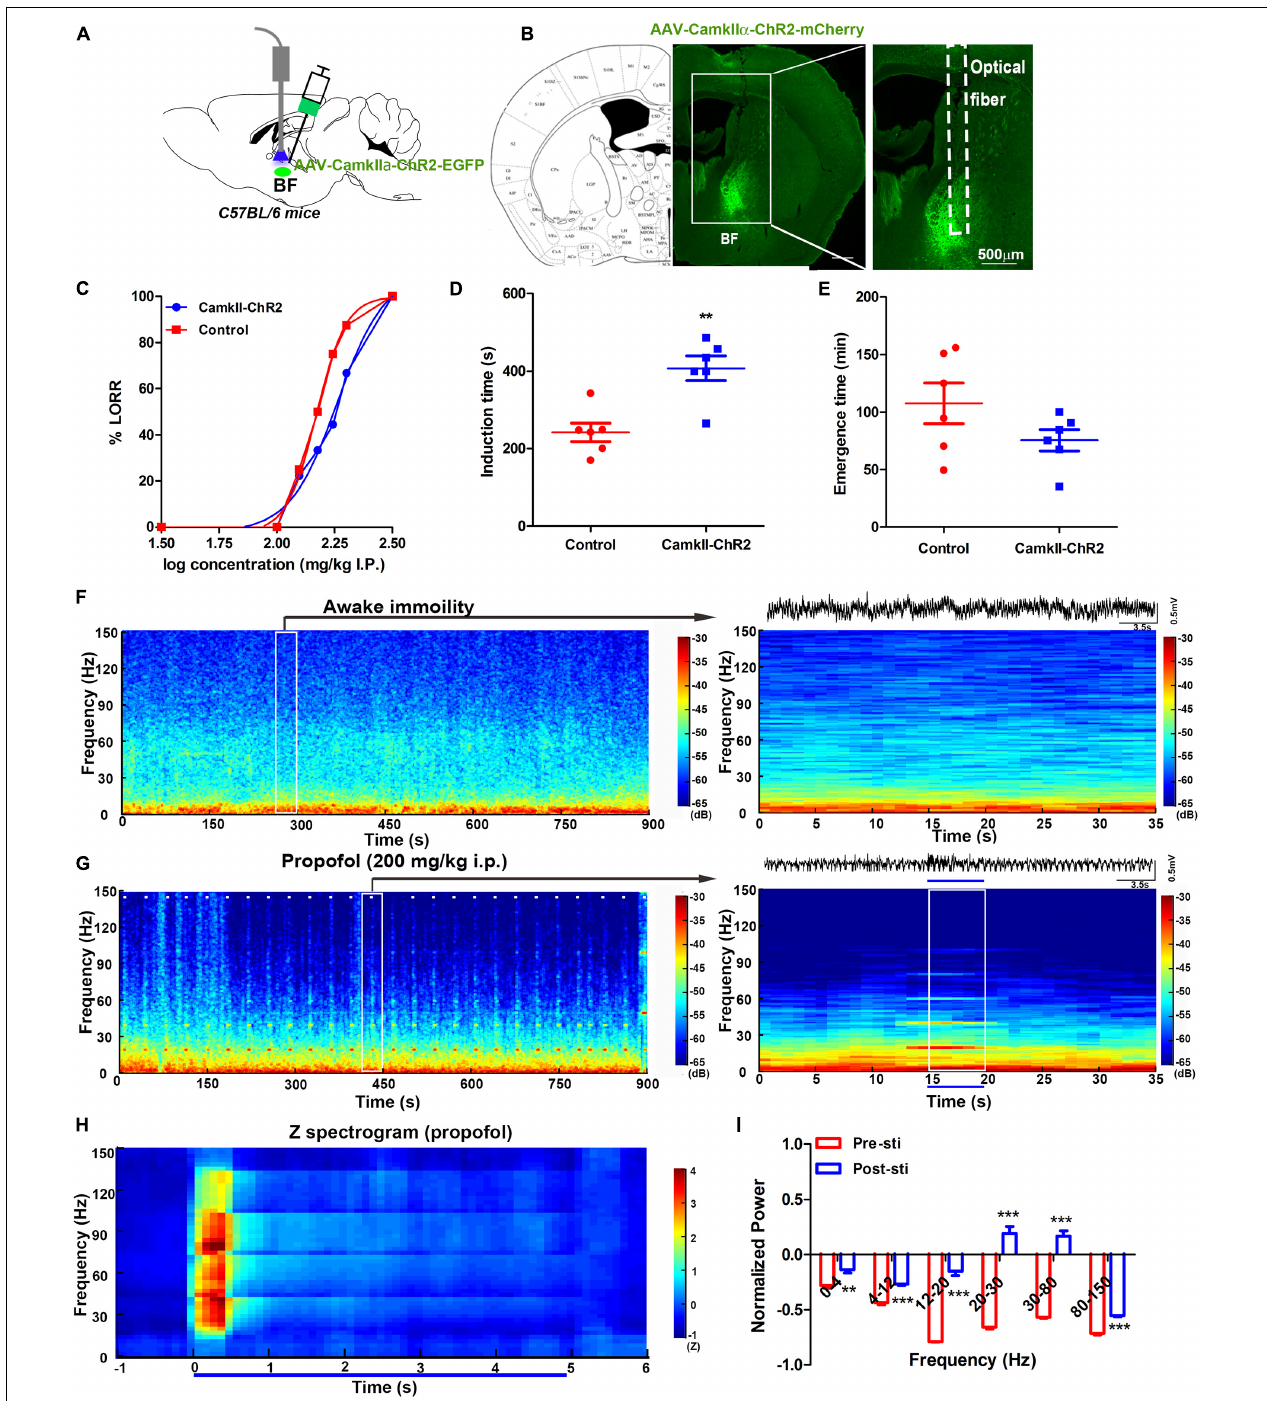
FIGURE 3 | Selective activation of glutamatergic neurons in the BF reversed propofol anesthesia with mPFC LFP change. (A) Schematic of optogenetic activation of BF glutamatergic neurons. (B) Selective expression of the AAV-CamKII-ChR2 virus in the BF glutamatergic neurons. (C) Dose-response curve from graded propofol after light stimulation (10 mice in both groups). Induction (D) and emergence (E) time after stimulation of BF glutamatergic neurons when exposed to propofol at a dose of 200 mg/kg (six mice in both). ∗∗ P < 0 . 01, compared with the control group. (F) Typical mouse spectrogram during the quiet awaking state for 15 min (left) and an enlarged 35 s time window with raw LFP data(right). (G) Typical mouse spectrogram during propofol anesthesia, accompanied by light stimulation for 15 min (left) and 35 s time window with raw LFP data (right), white dashes (left) and the blue line (right) represent light stimulation. (H) Normalized spectrogram computed from six mice under light stimulation during propofol at 200 mg/kg trial = 51). (I) Post hoc analyses at 0–4, 5–12, 12–20, 20–30, 30–80, and 80–150 Hz for 5 s before and after light stimulation during propofol at 200 mg/kg. “0” means the onset of propofol administration in the Figures (F,G) . ∗∗ P < 0 . 001 and ∗∗∗ P < 0 . 001, compared with the pre-sti group at every frequency